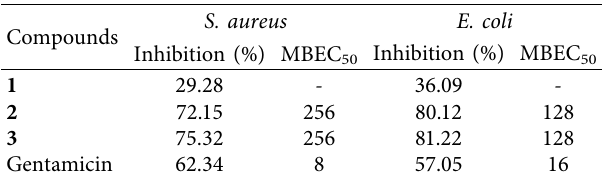
Table 2: Percentage of bioflm inhibition (%) and the minimum bioflm eradication concentration (MBEC 50 ) values of some iso- lated compounds against S. aureus and E. coli strains.